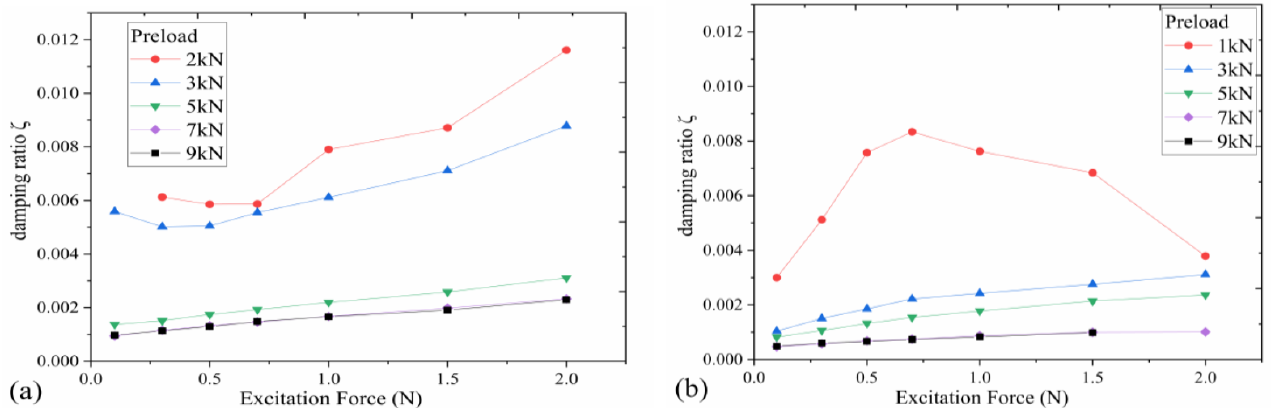
Figure 20. Influence of the excitation force on the identified modal damping ratio, ( a ) two-beam joint, ( b ) one monolithic beam.